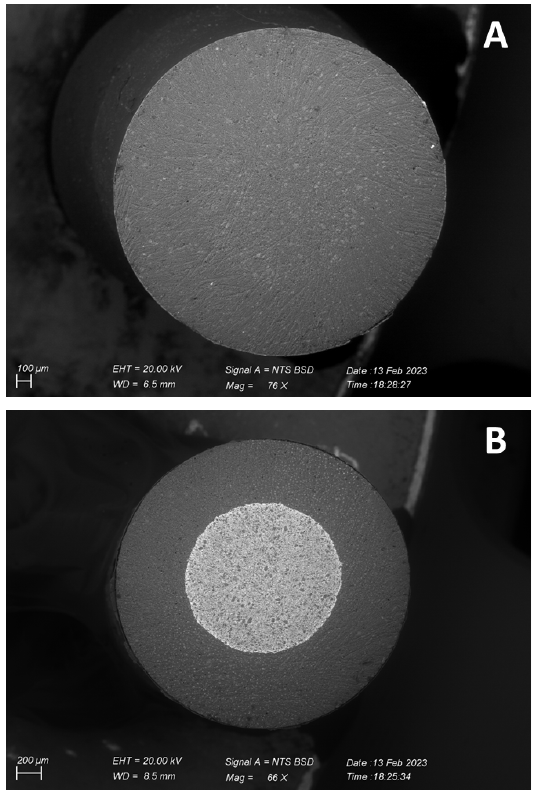
Figure 6. Scanning electron micrographs of control CCR (Panel ( A ), 76× of magnification) and platinized CCR (Panel ( B ), 66× of magnification).